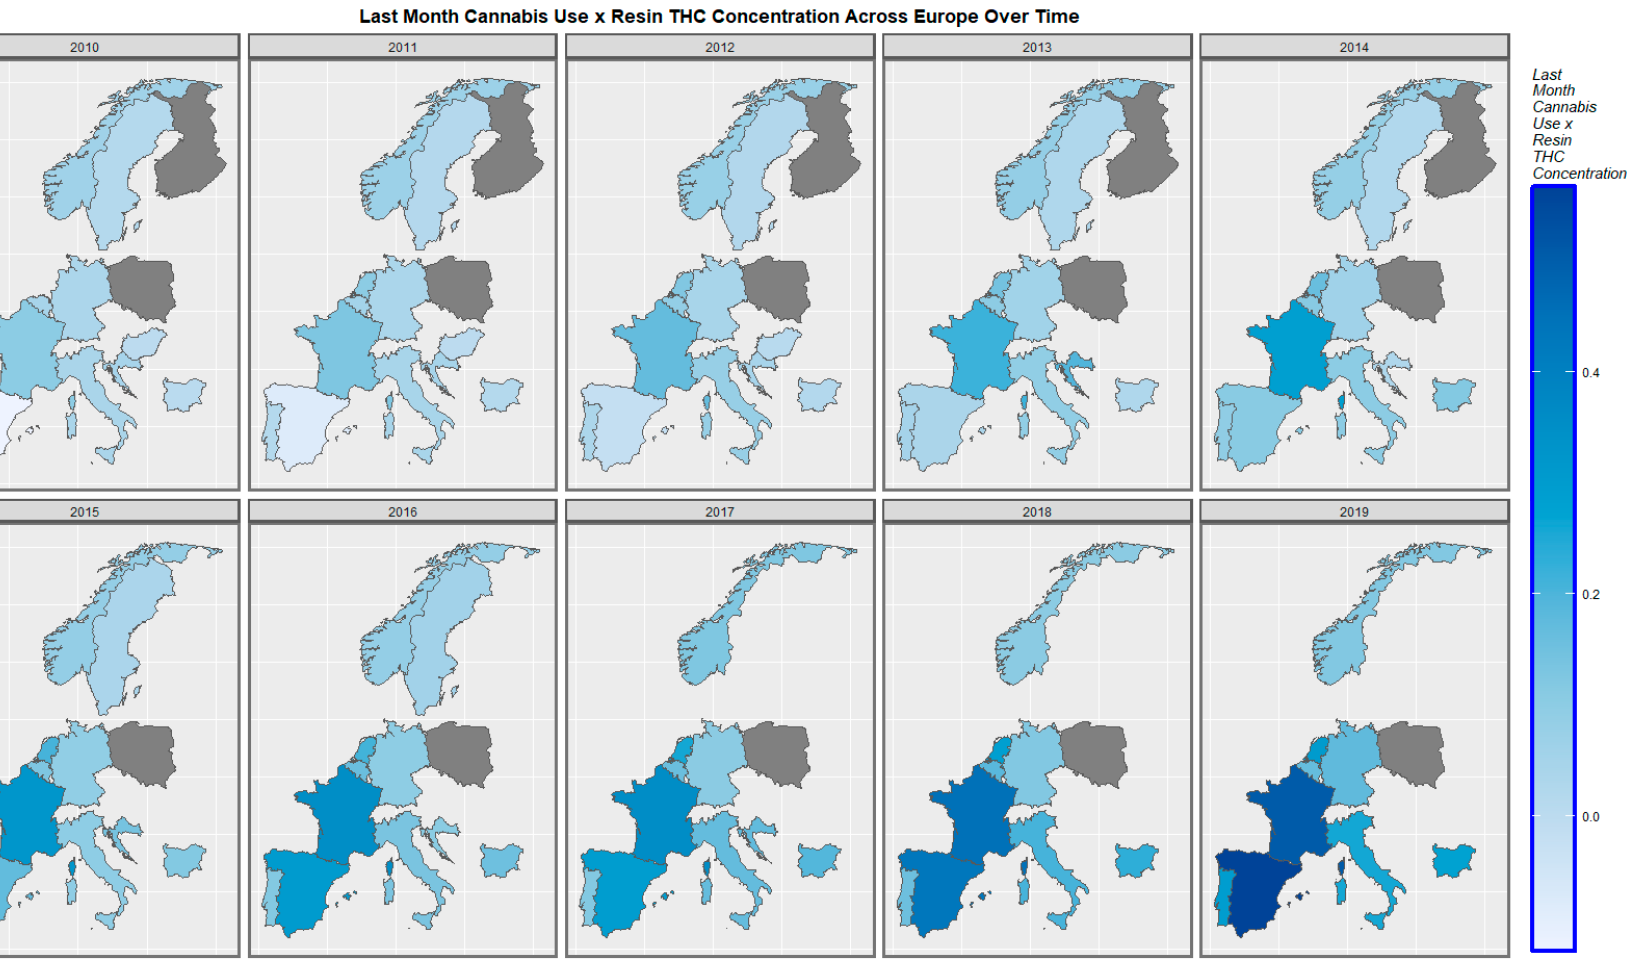
Figure 7. Sequential map-graph of last month’s cannabis use: cannabis resin THC concentration across selected European nations for each year of 2010–2019.